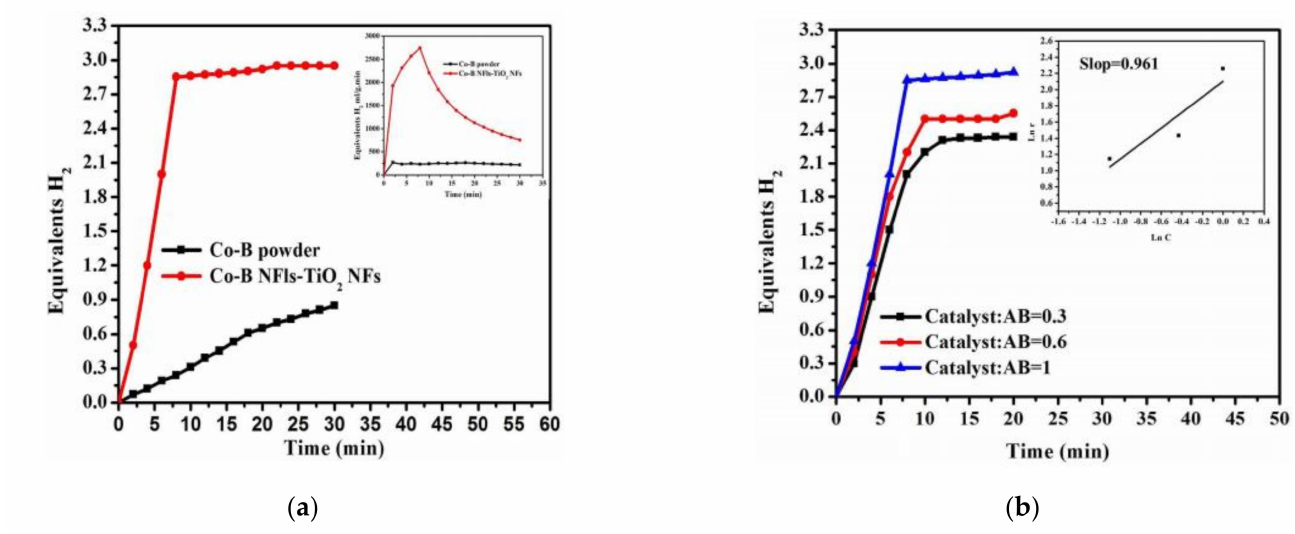
Figure 12. ( a ) Catalytic performance of Co-B NPs and Co-B NFs-TiO 2 NFs in hydrolysis AB reaction. ( b ) Effect of metal concentration on H 2 generation. Reprinted from reference [99] with permission from